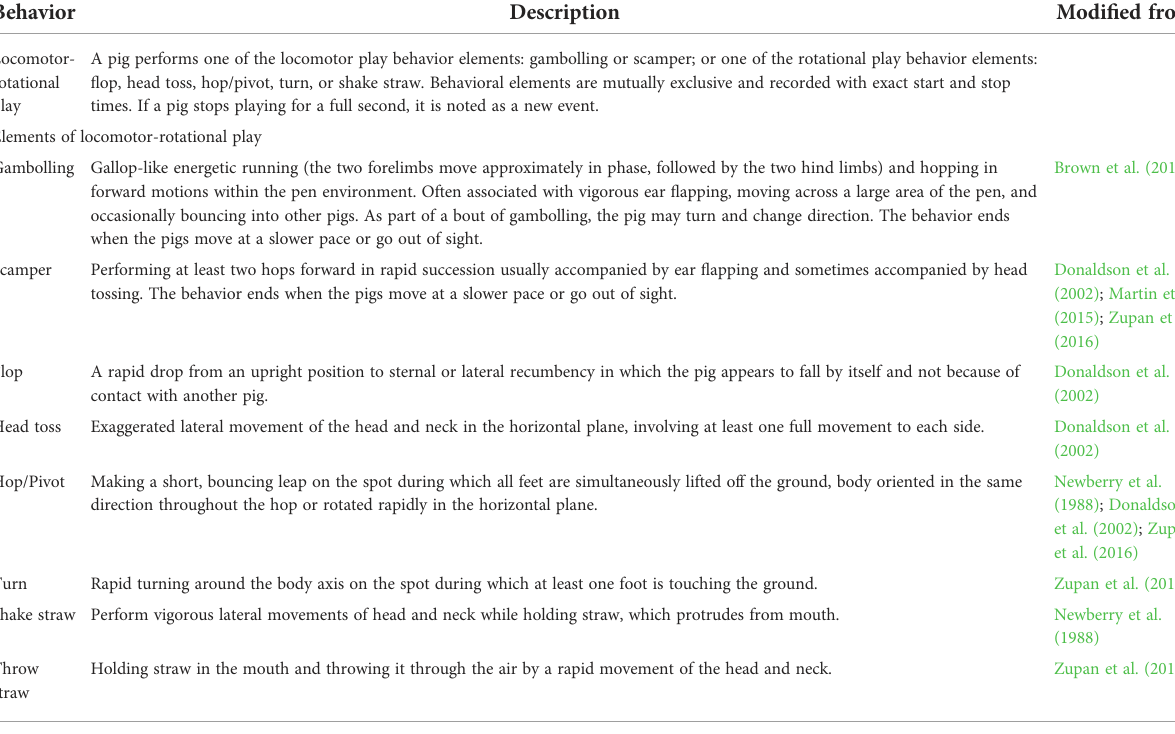
TABLE 1 Ethogram of behavioral elements constituting locomotor-rotational play in domesticated pigs ( Sus scrofa ). Behavior Locomotor-